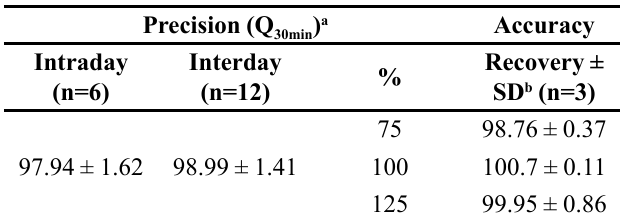
TABLE II - Precision and accuracy of the dissolution method for